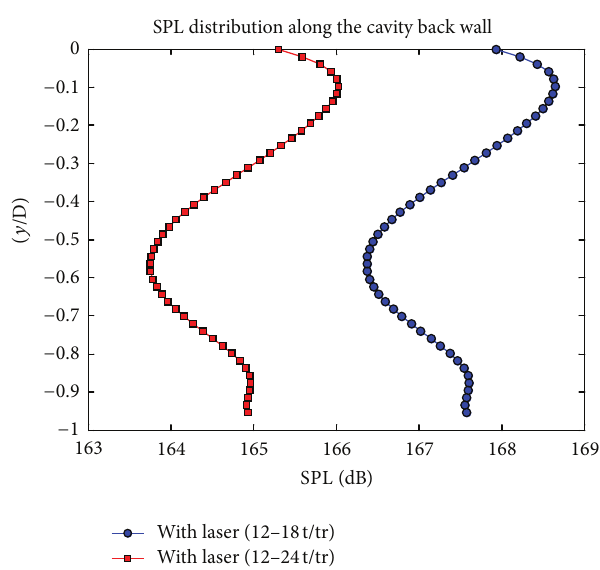
Figure 4: SPL distribution along the cavity back wall (comparison between 12–18t/tr and 12–24